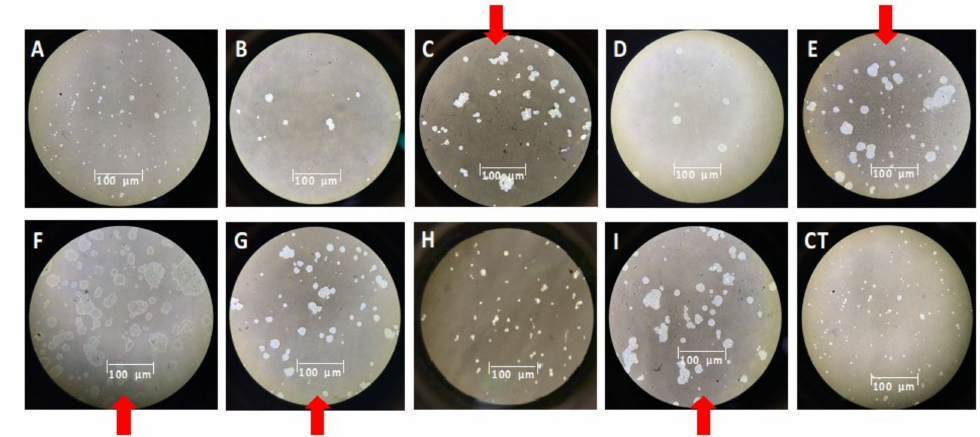
Figure 4. Effect of lactones on colony morphology (10X) of M. aeruginosa . 3-oxodecanoyl ( A ), N- (3-oxododecanoyl)-L-homoserine lactone ( B ), N-hexanoyl-L-homoserine lactone ( C ), N-decanoyl ( D ), heptanoyl ( E ), N-dodecanoyl-L-homoserine lactone ( F ), N-octanoyl ( G ), N-(3-oxooctanoyl)-L- homoserine lactone ( H ), butyryl-DL-homoserine lactone ( I ). The red arrows show the largest colonies. Lactone F induced more colonies of larger size, while lactones C, E, H, G, and I only induced more colonies. A more negligible effect was observed with lactones B and D, but lactone A was virtually